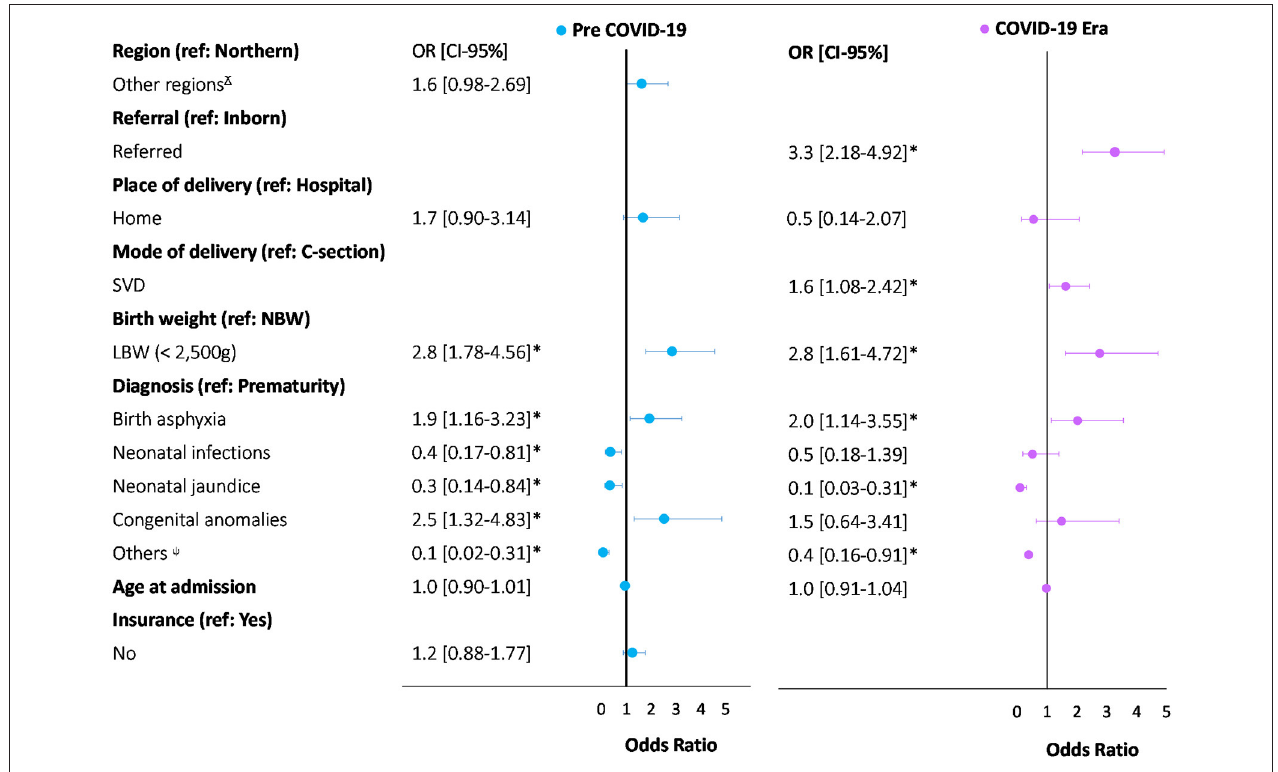
FIGURE 2 | Comparison of multivariate logistic regression for predictors of neonatal death between pre-COVID-19 and COVID-19 era in TTH NICU. *Statistiscally significate ( p < 0.05). È Includes: Ashanti, Bono, Bono East, North East, Oti, Savannah, Upper East, Upper West. ψ Includes: pemphigous, dehydration, meconium aspiration syndrome, respiratory distress syndrome, retro-exposed, malnutrition, normal baby, stable baby, birth injuries, hematological diseases, neonatal seizures, low birth weight, and macrosomia. Pre-COVID-19 was defined as neonatal admissions from March 1st to August 31st, 2019. COVID-19 era was defined as neonatal admissions from March 1st to August 31st,